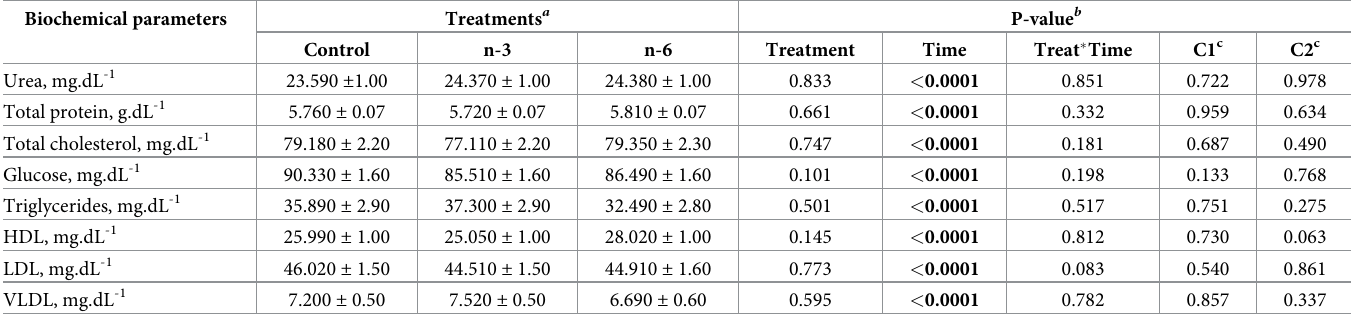
Table 5. Effect of supplementation of milk enriched with n-3 and n-6 on serum biochemical parameters of gilts from 34 to 190 days of age. Biochemical